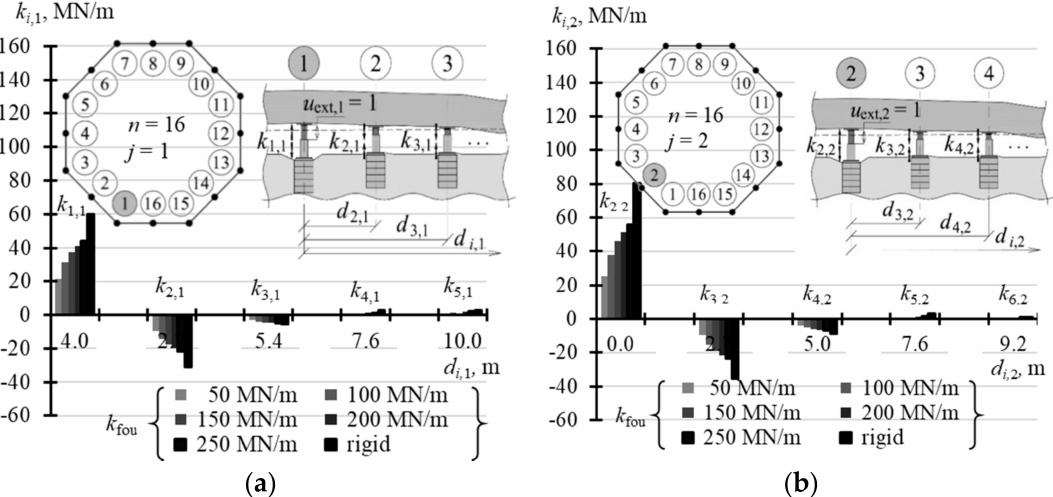
Figure 16. Selected elements of the stiffness matrix k for the structure for different stiffness values k fou of the jack supports when n = 16: ( a ) elements k i, 1 ; ( b ) elements k i, 2